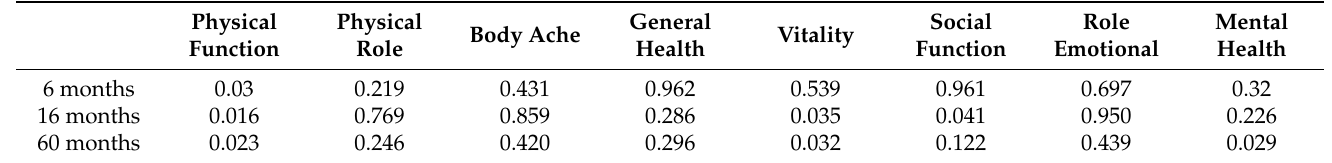
Table 5. Degree of significance of the comparisons of the health scales of the SF-36 Questionnaire at 6 and 60 months after the intervention in the EVAR and OAR groups (Kruskal–Wallis test). Open abdominal repair (OAR), endoprosthesis abdominal repair